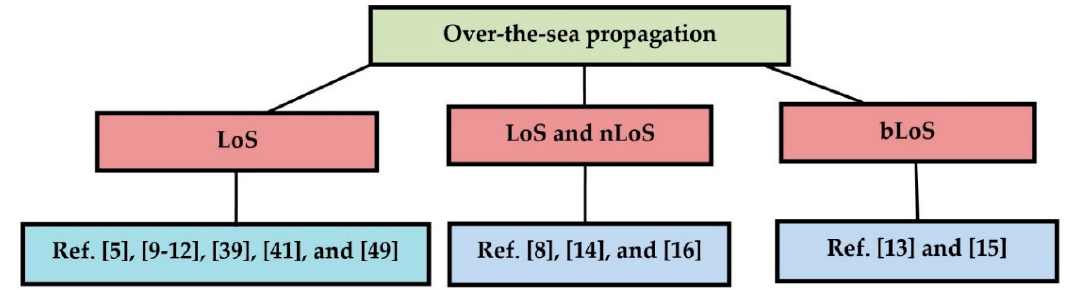
Figure 9. Classification of channel models based on wave propagation scenarios.